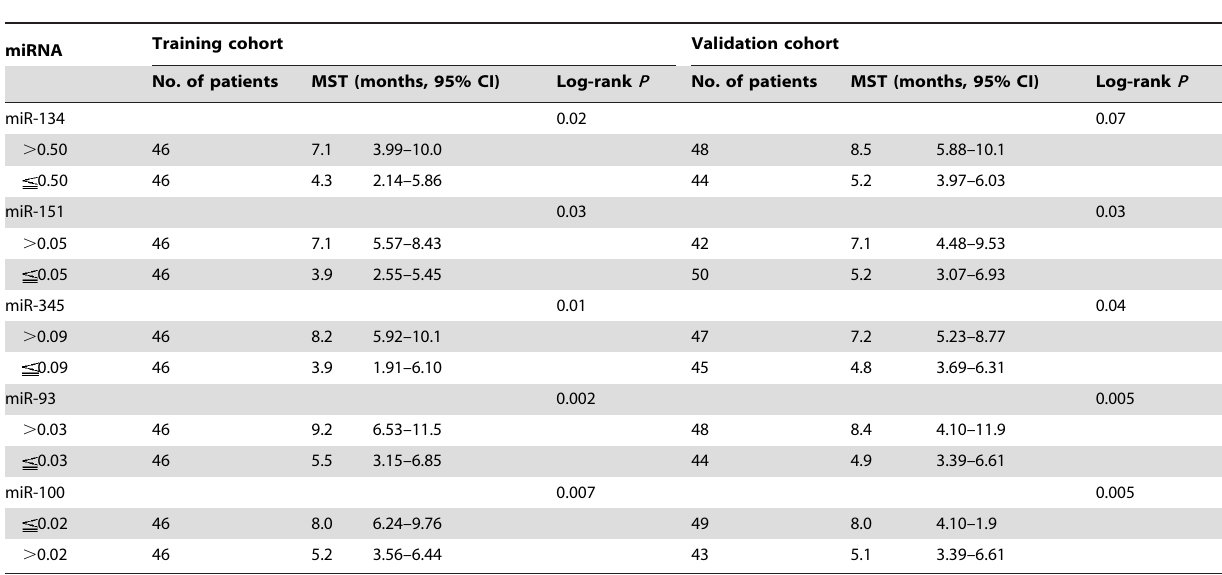
Table 2. Effusion expression levels of five miRNAs and survival of patients with lung cancers in training and validation